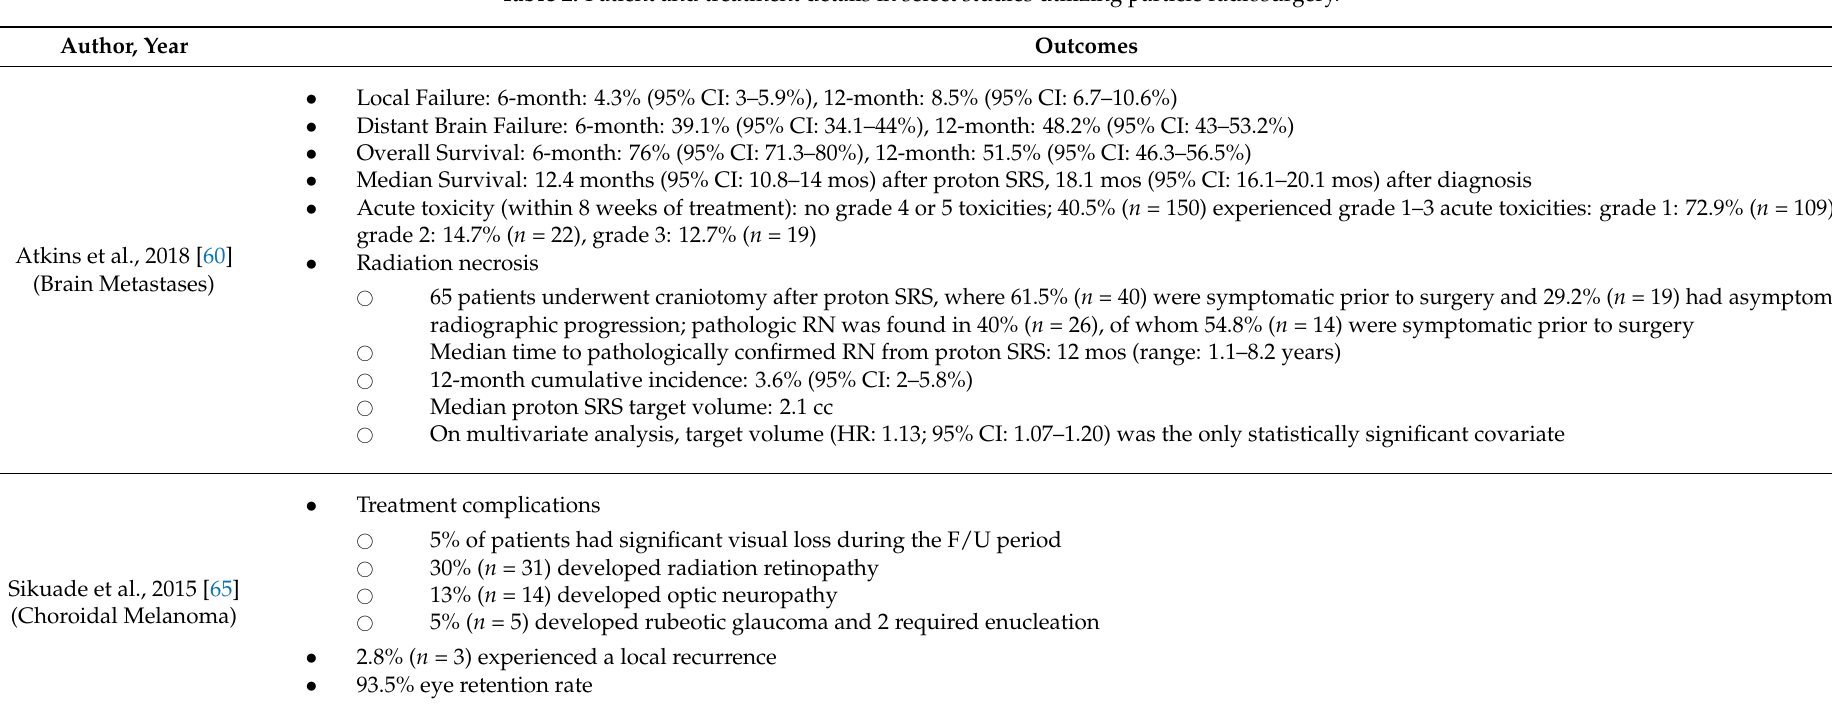
Table 2. Patient and treatment details in select studies utilizing particle